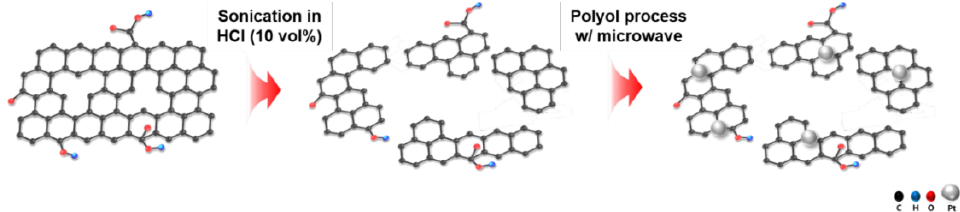
Figure 1. Schematic illustration of the synthesis of Pt/srGO.